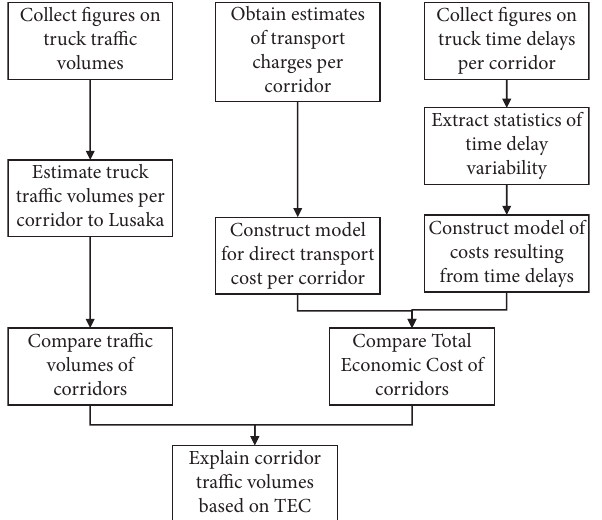
Figure 2: Schematic description of the